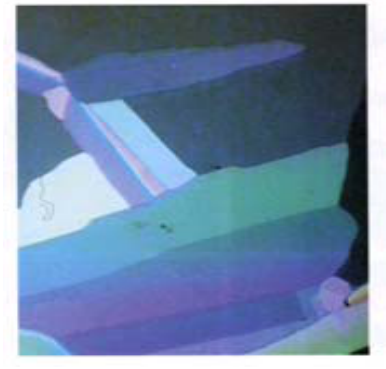
Figure 8. The mosaic texture is a common appearance of the smectic B phase as reported in the literature [40]. The mosaic textures are usually characterized by area of uniform optical appearance mediated by grain boundaries. The texture is very consistent with our observations in Figures 6e and